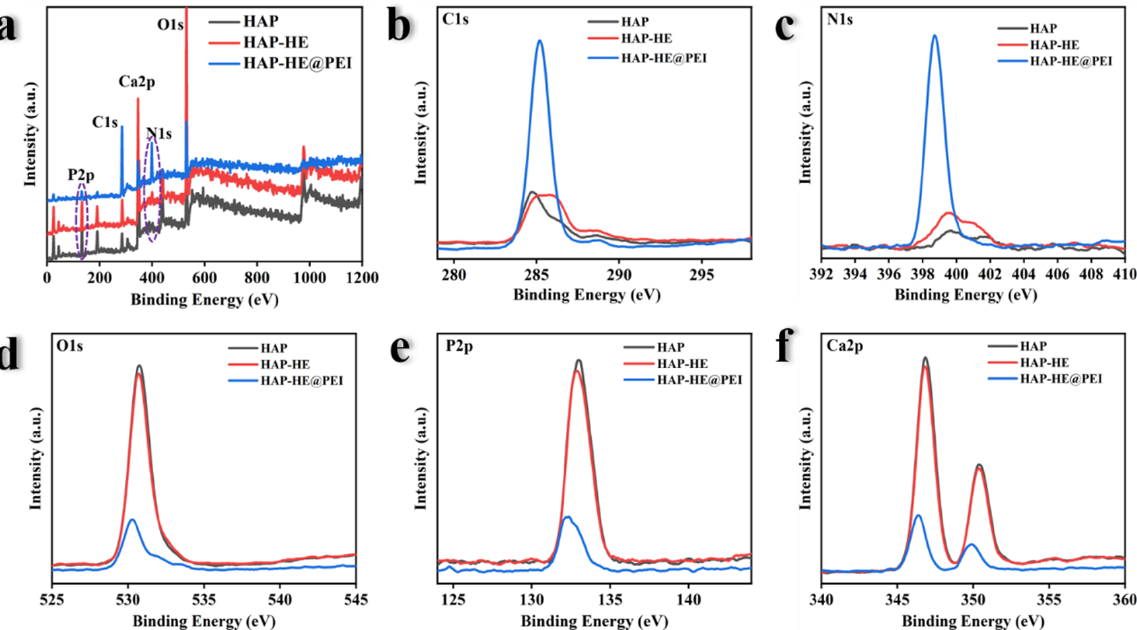
Figure 3. XPS spectra of HAP, HAP − HE and HAP − HE@PEI. ( a ) Survey scan ranging from 0 to 1200 eV, the High-resolution spectra of ( b ) C1s, ( c ) N 1s, ( d ) O 1s, ( e ) P2p and ( f )